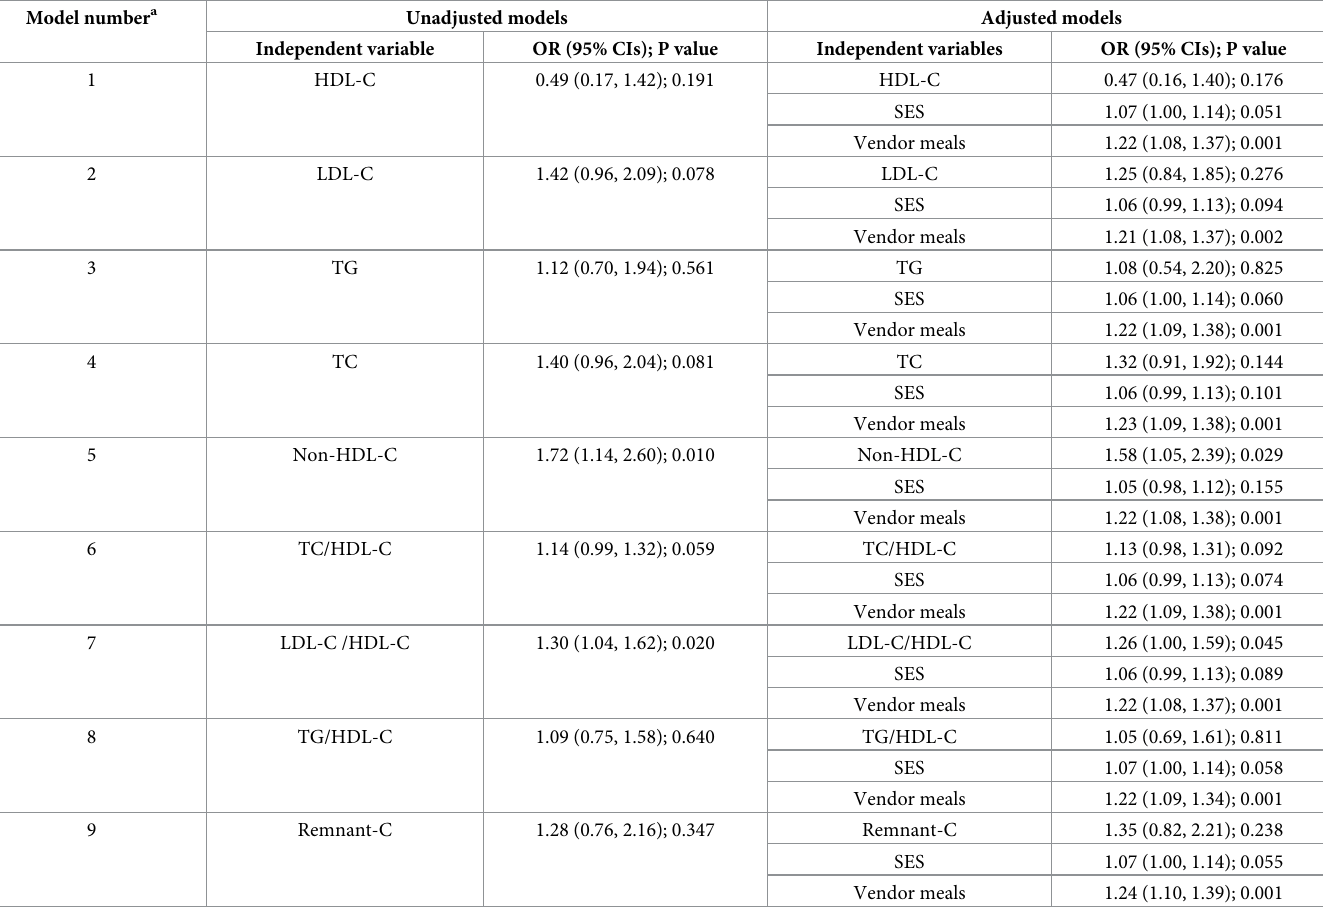
Table 3. Logistic regression analyses of lipid metrics associated with self-reported CVD before and after covariate